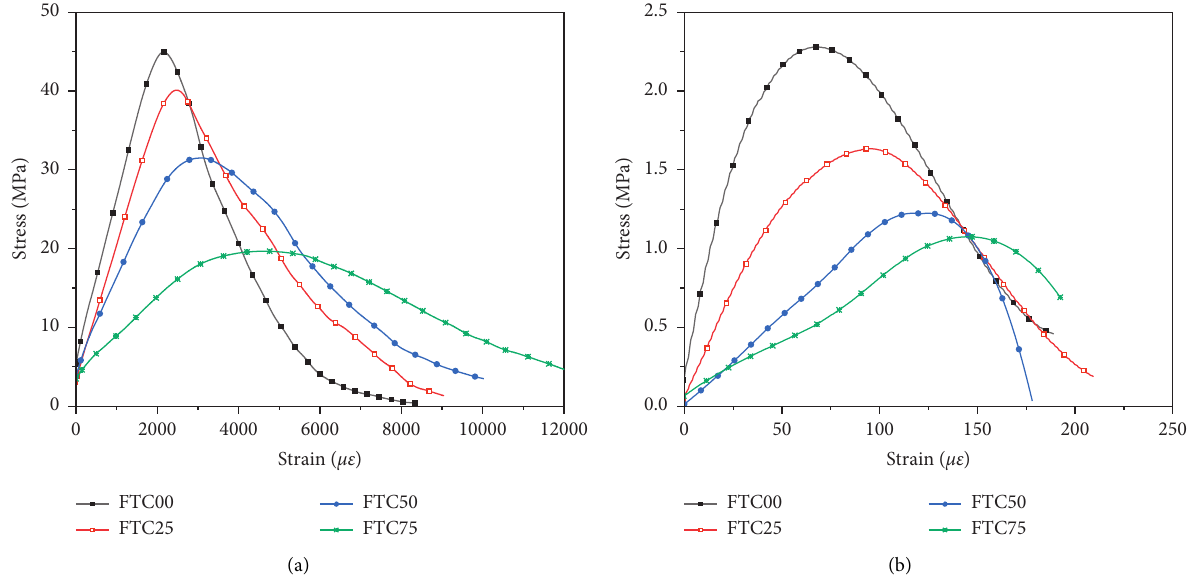
Figure 3: Complete compressive and split tensile stress-strain full curve of concrete after freeze-thaw influence: (a) uniaxial compression; (b) split tensile. Table 1: Static compression and split tensile data of concrete after different numbers of freezing-thaw cycles. Number of freeze-thaw